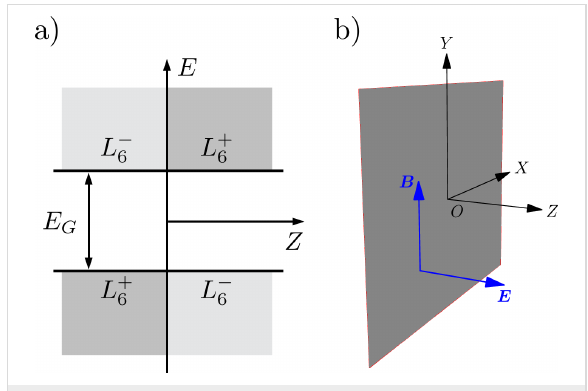
Figure 1: (a) and band-edge profile of an abrupt band-inverted junction with aligned and same-sized gaps, located at the XY -plane, and b) schematic view of the applied electric and magnetic fields. Figure 1b. By choosing the Landau gauge, the vector potential is given as